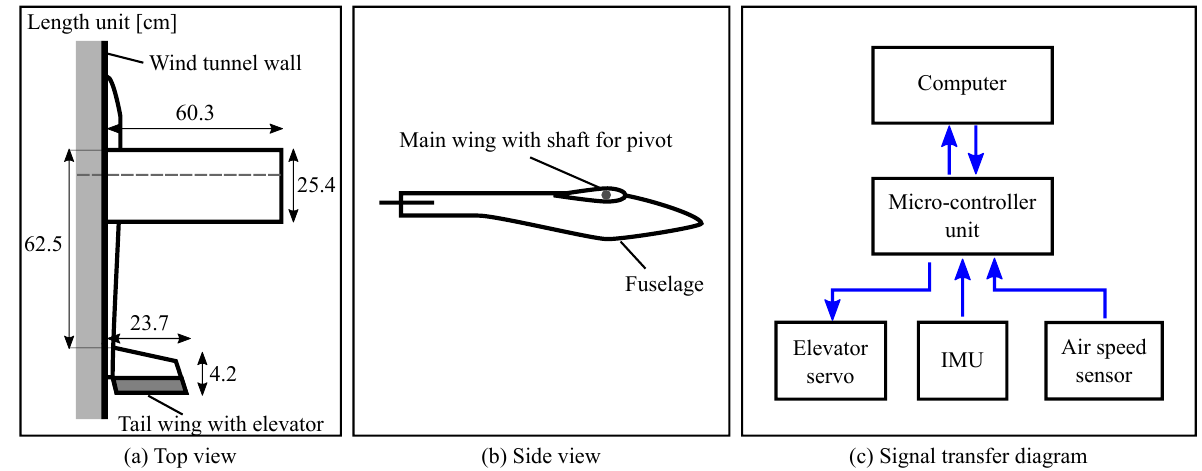
Figure 1. Schematics of the experimental configuration.